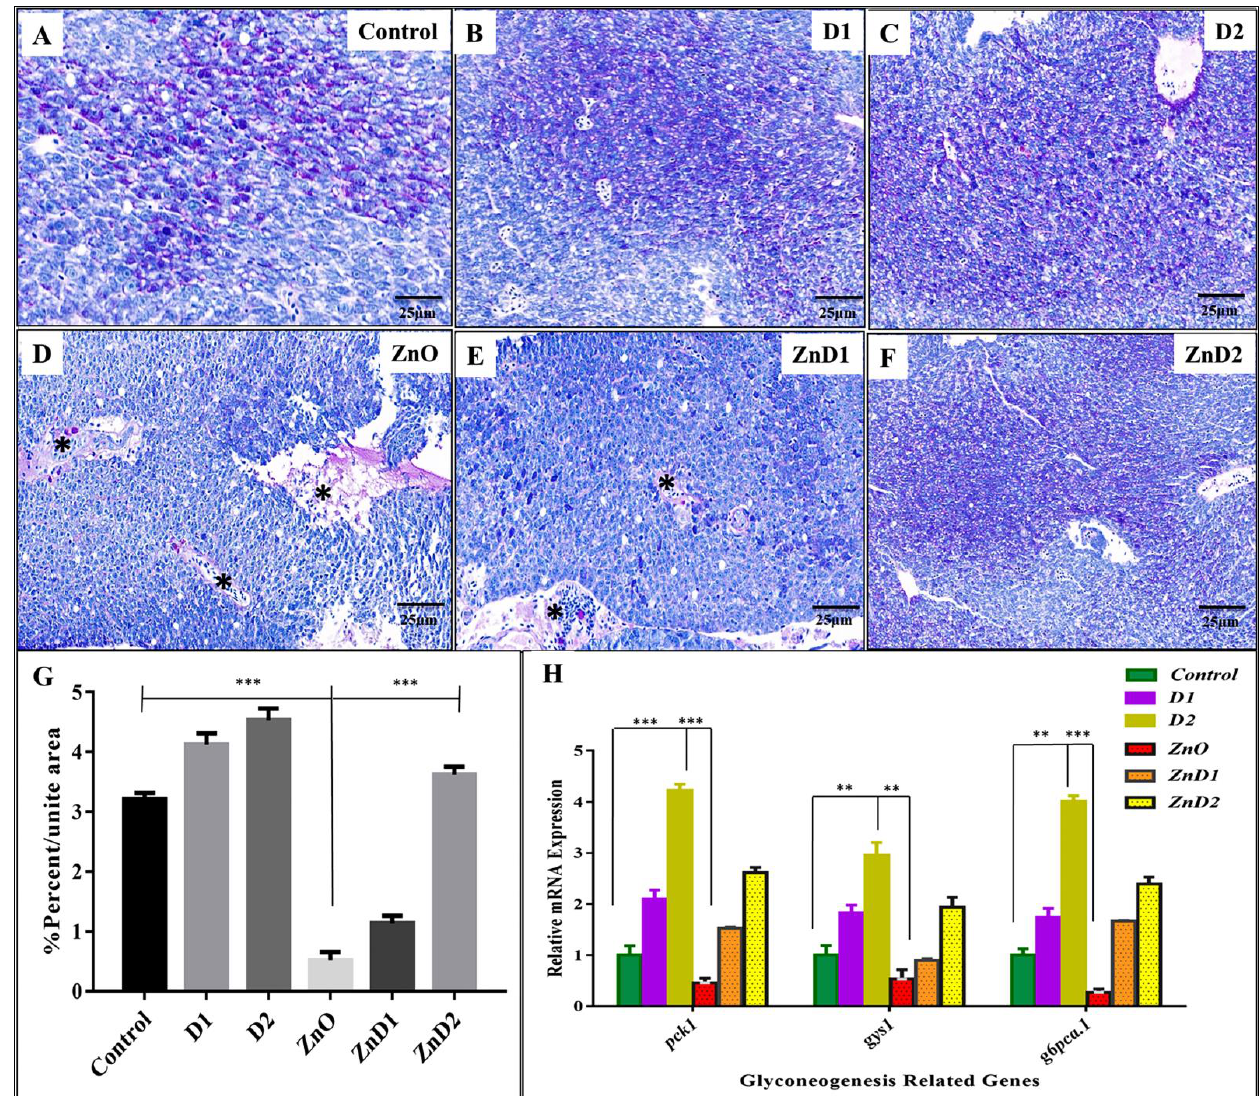
Figure 5. D. salina restored fish appetite and induced hepatic gluconeogenesis: ( A ) – ( C ) Periodic acid Schiff (PAS) stained liver sections of control zebrafish, D1, and D2 groups showing normal glycogen contents; notice glycogen content in the D2 group is more than in D1 and the control groups (purple staining); ( D ) representative photomicrograph of ZnO-NPs exposed group stained with PAS showing hepatic tissue degeneration, inflammatory cellular infiltration (Black asterisk), and absence of hepatic glycogen; ( E , F ) representative photomicrographs of PAS staining for ZnD1 and ZnD2 groups, respectively. ZnD2 is more effective in restoring liver structure and hepatic glycogen content; ( G ) statistical analysis of the glycogen-covered area (the average percentage for triple readings); ( H ) mRNA expression evaluated by qRT-PCR for gluconeogenesis-related genes indicating downregulation of gene expression in the ZnO-NPs group, which is upregulated after dietary supplementation with D. salina , especially in ZnD2 groups. Magnification is shown in all pictures. The results are shown as the mean ± SD.* p < 0.05 (significant), ** p < 0.01(highly significant), *** p < 0.001 (very high significant).